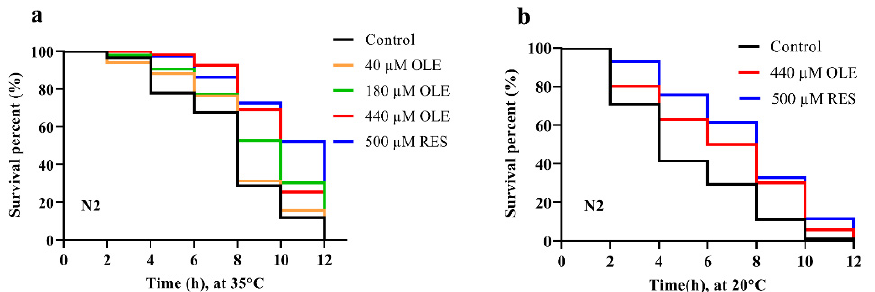
Figure 3. OLE increased the mean lifespan of N2 worms under ( a ) heat and ( b ) oxidative stress.